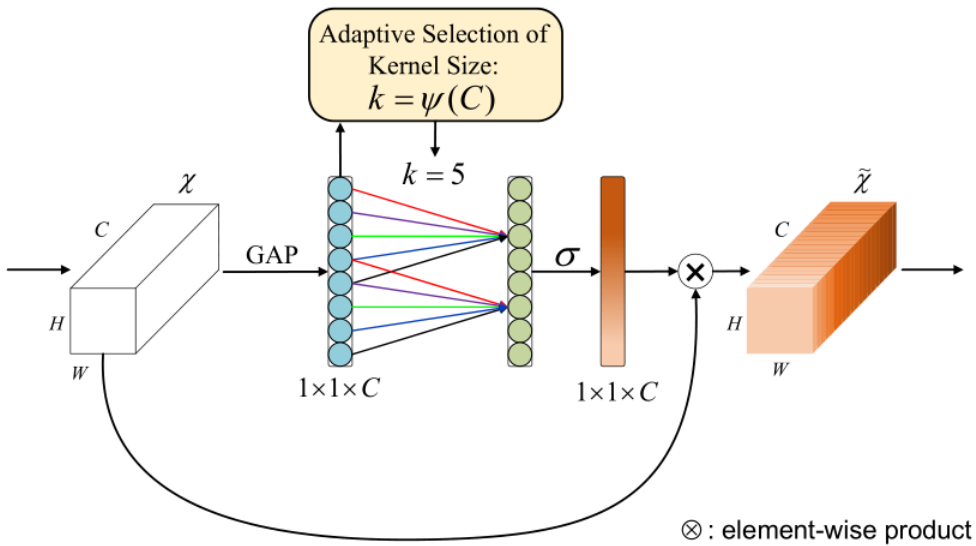
Figure 5. Diagram of ECA module [20]. X denotes output of the convolution layer, H, W and C denote the height, width and channel dimension of the convolution block, GAP denotes the global average pooling, k is the adaptively selected convolution kernel size, and σ is the Sigmoid activation function.